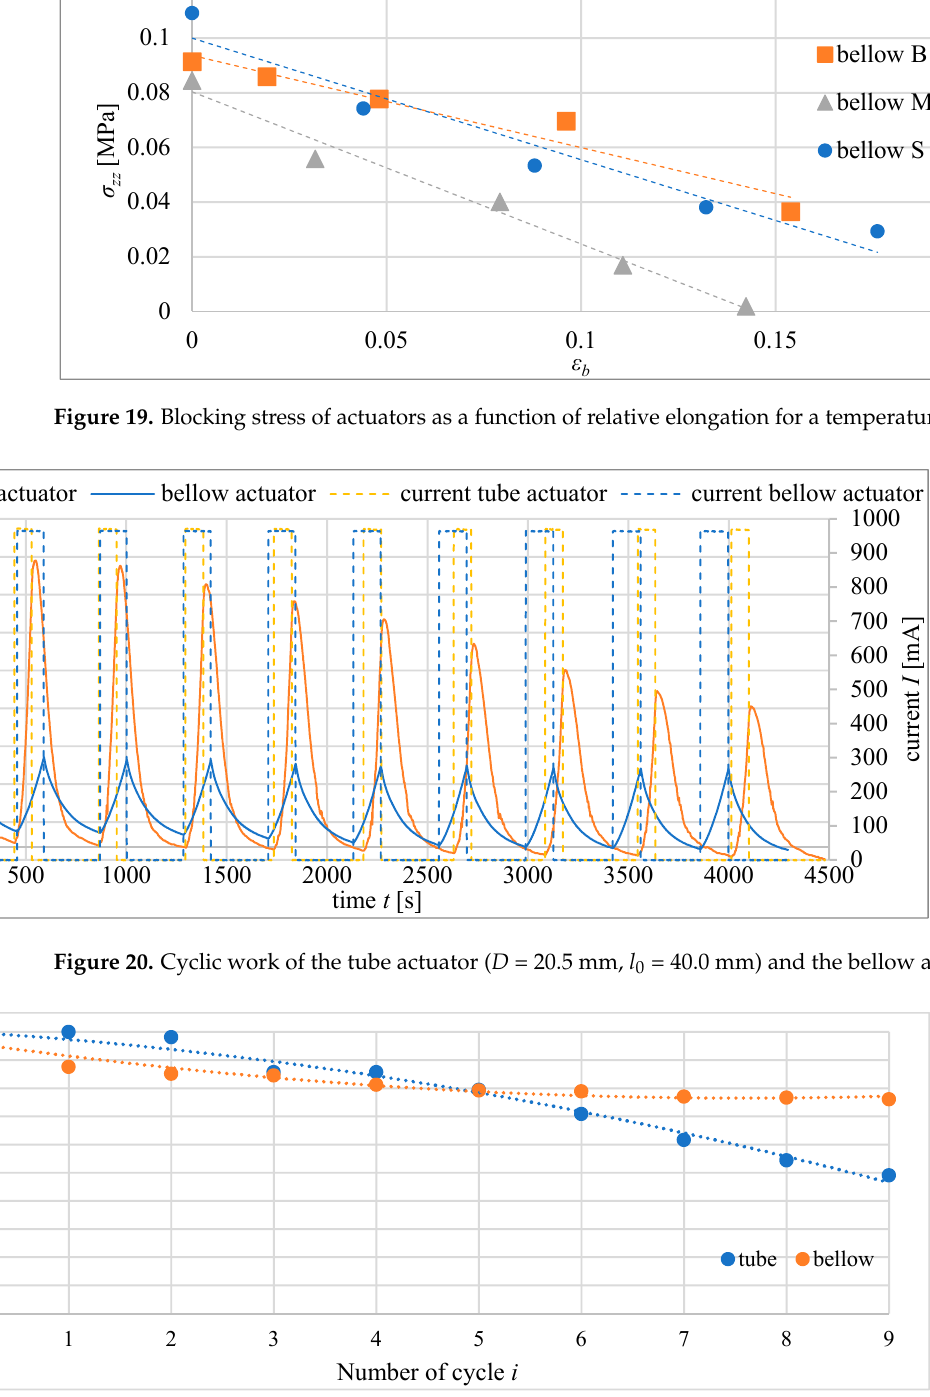
Figure 21. Composite wear in tube and bellow actuator. Figure 20. Cyclic work of the tube actuator ( D = 20.5 mm, l 0 = 40.0 mm) and the bellow actuator S.